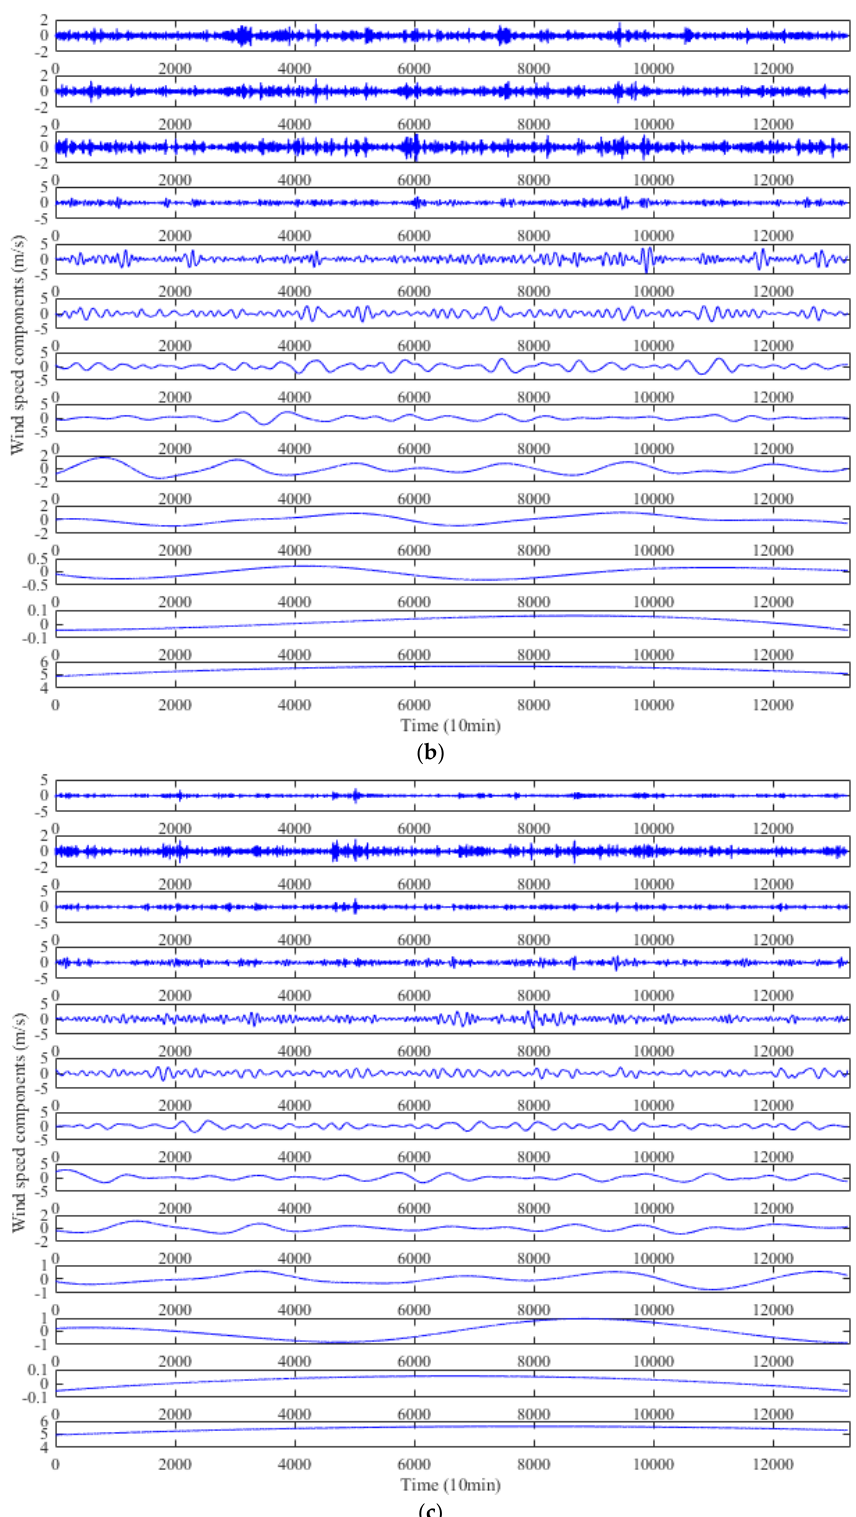
Figure 6. The decomposition results of wind speed series: ( a ) Case A; ( b ) Case B; ( c ) Case C.